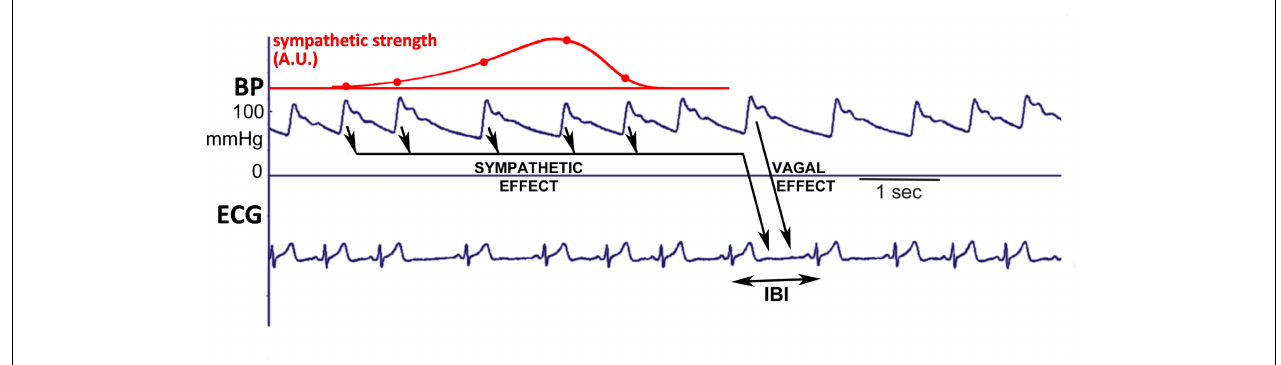
FIGURE 1 | Schematic diagram to explain how the simulated IBI-data were generated. The systolic pressure is considered to rapidly affect the length of the ongoing IBI, due to the vagal effect. In addition, the values of diastoles/systoles activate the sympathetics: lower pressure values cause more activity, inducing a shorter IBI. After a pressure change, the effect on IBI starts slowly, but lasts for some seconds, and so the considered IBI is affected by several past pressure-values, as depicted by the arrows. The dots on the red line indicate the relative contributions of each of these previous pressure values to the ongoing beat duration, in addition to the vagal